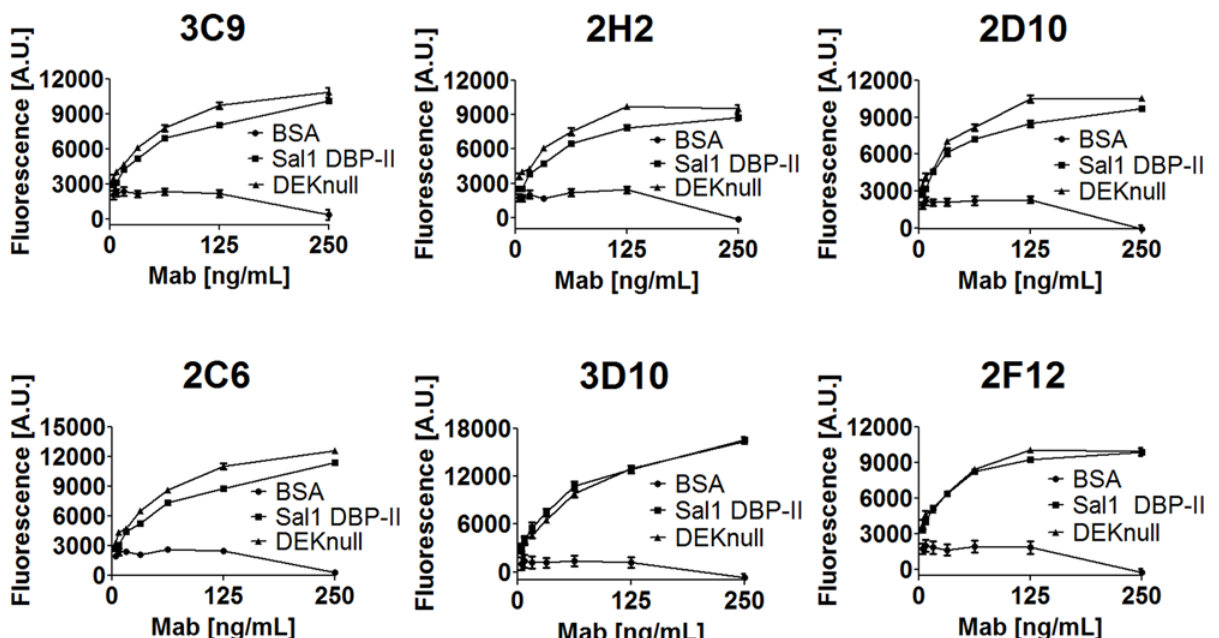
Fig 5. ELISA with anti-DBP conformational specific antibodies. ELISA assays for conformational anti-DBP antibodies with BSA as a negative control, Sal1 DBP-II as a positive control, and DEKnull protein. Four inhibitory (3C9, 2H2, 2C6, 2D10) and two non-inhibitory (3D10, 2F12) antibodies were tested.